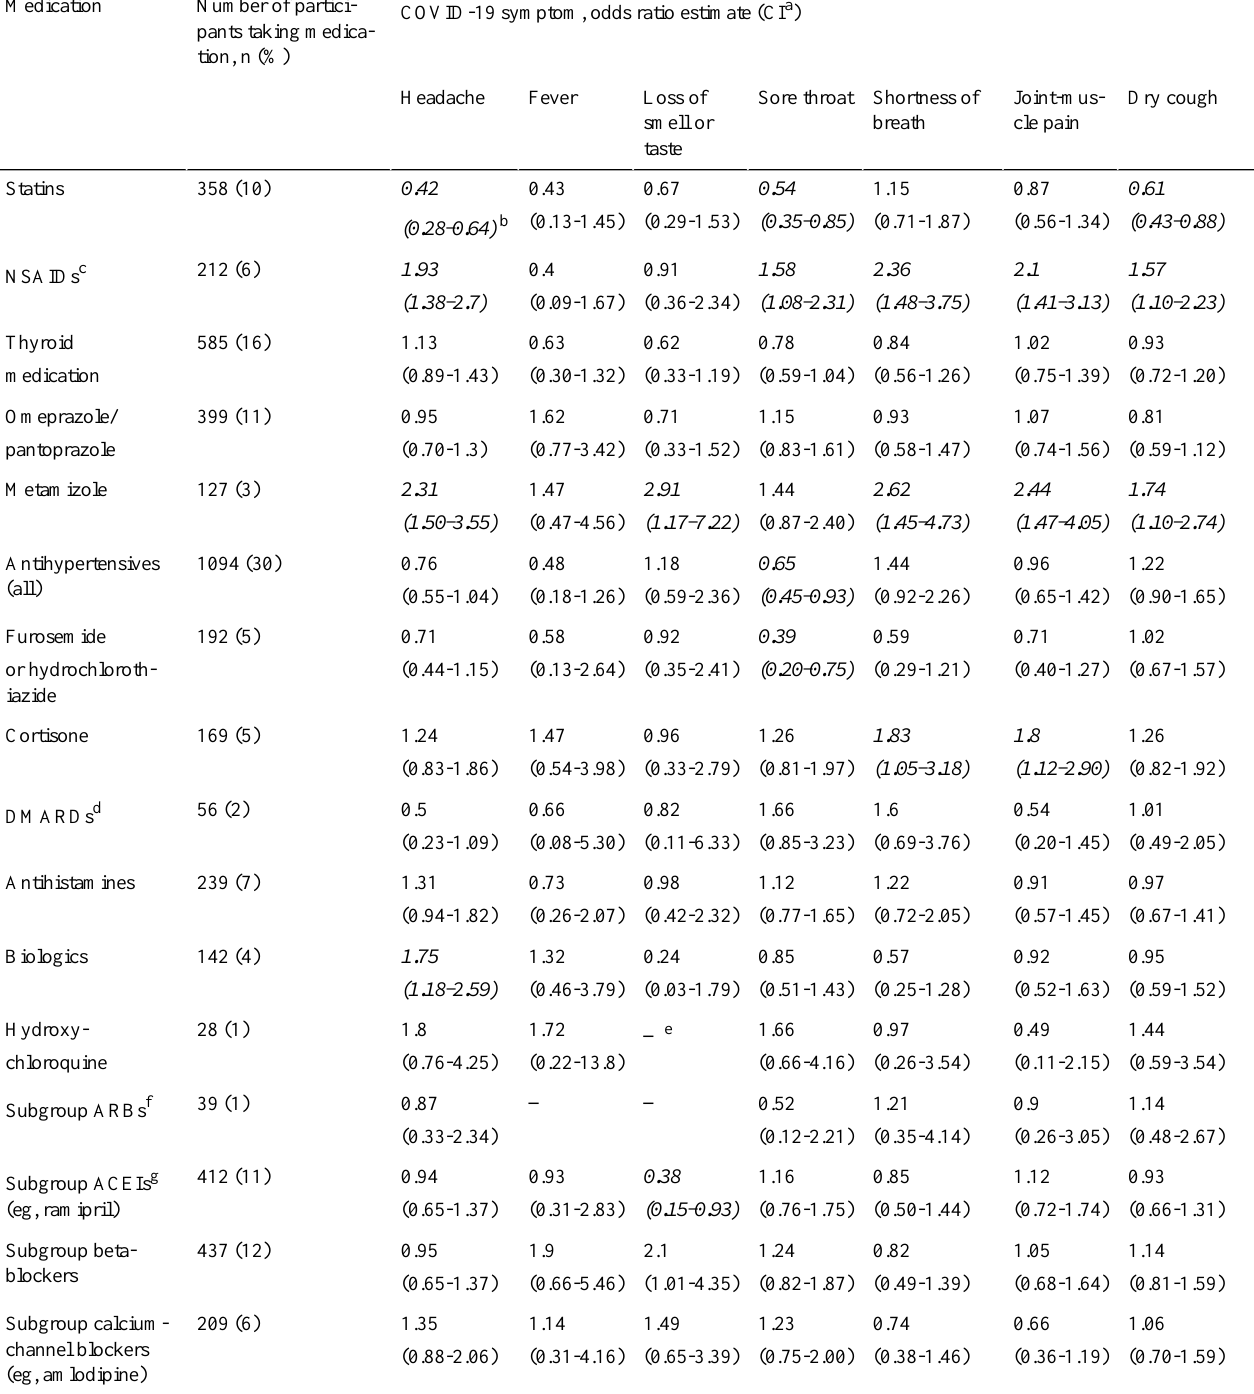
Table 2. Strength of association between medication and odds of typical COVID-19 symptoms that were self-reported